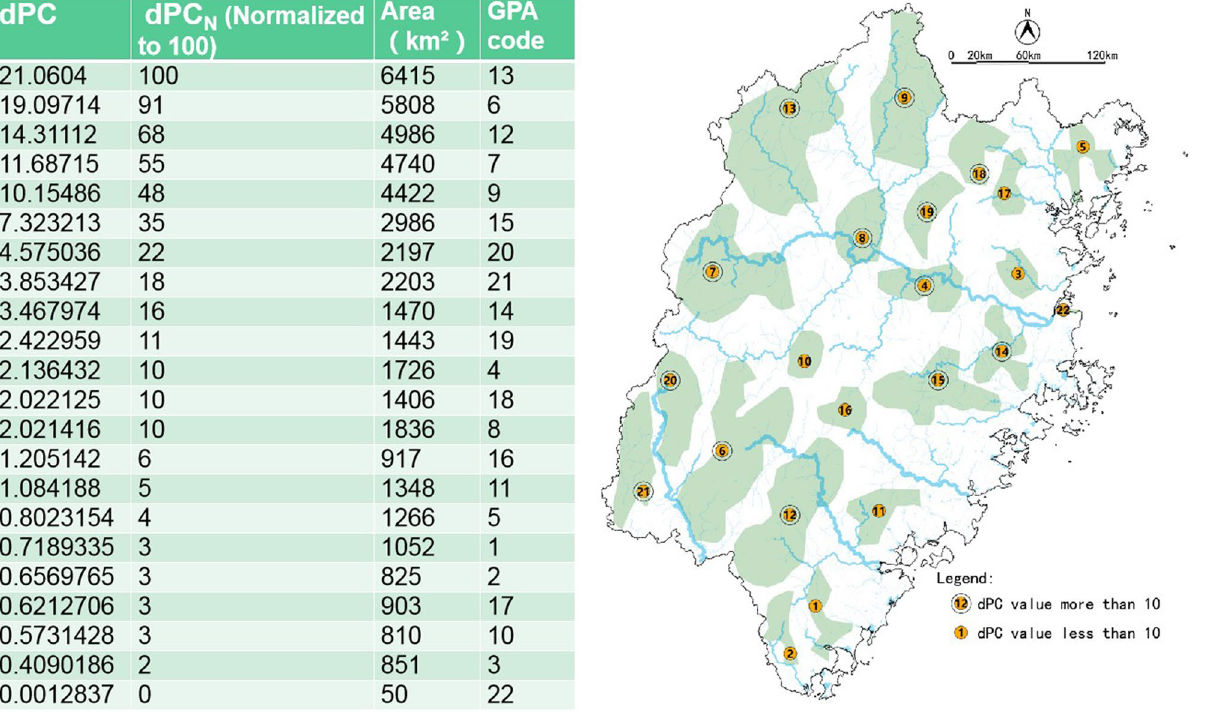
Figure 15. The dPC value of GPAs in Fujian Province.